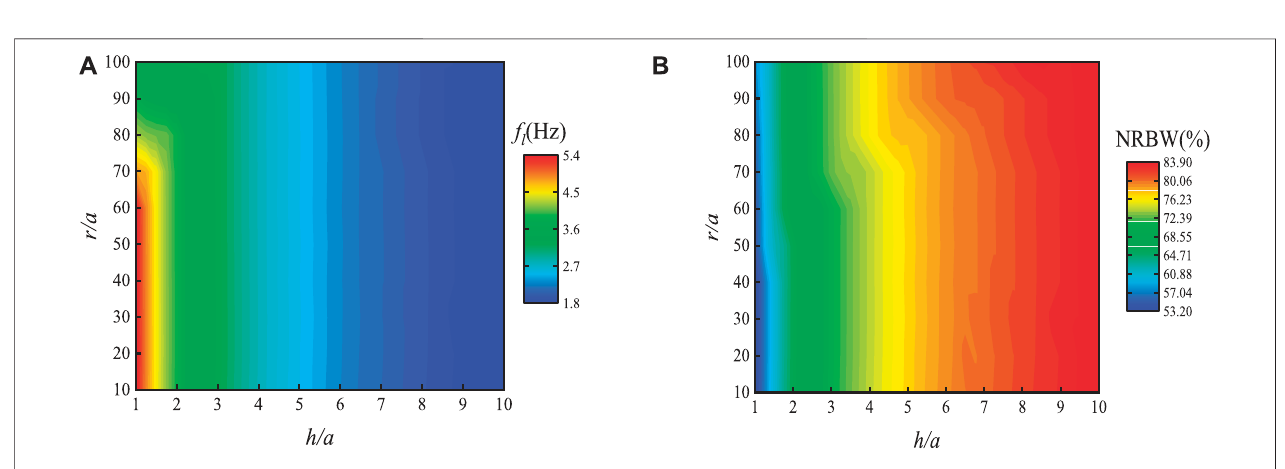
FIGURE 9 | Relationship between bandgaps characteristics and parameter ratio h/a and r/a : (A) the lower frequency bounds of the fi rst bandgaps ( f l ); (B) the relative band width of bandgap (NRBW).